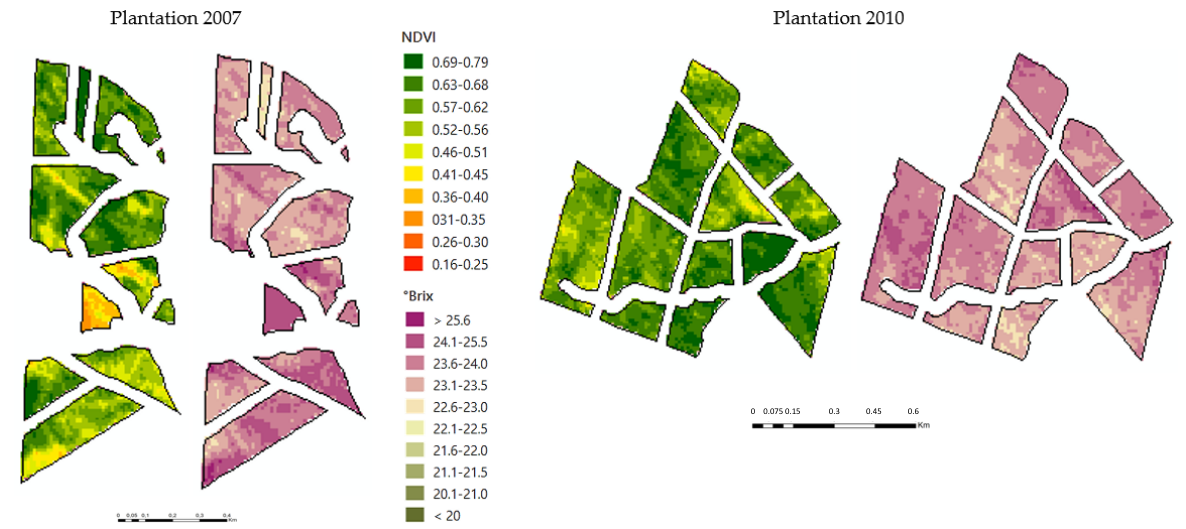
Figure 12. NDVI and ◦ Brix model maps, 2018 season.